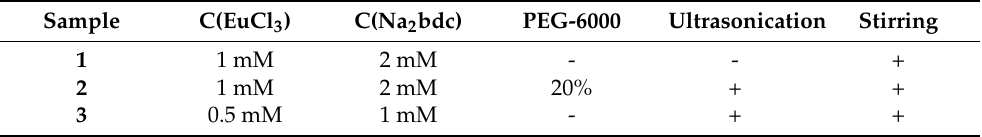
Table 1. Overview of the synthesis of europium(III) terephthalates 1 – 3